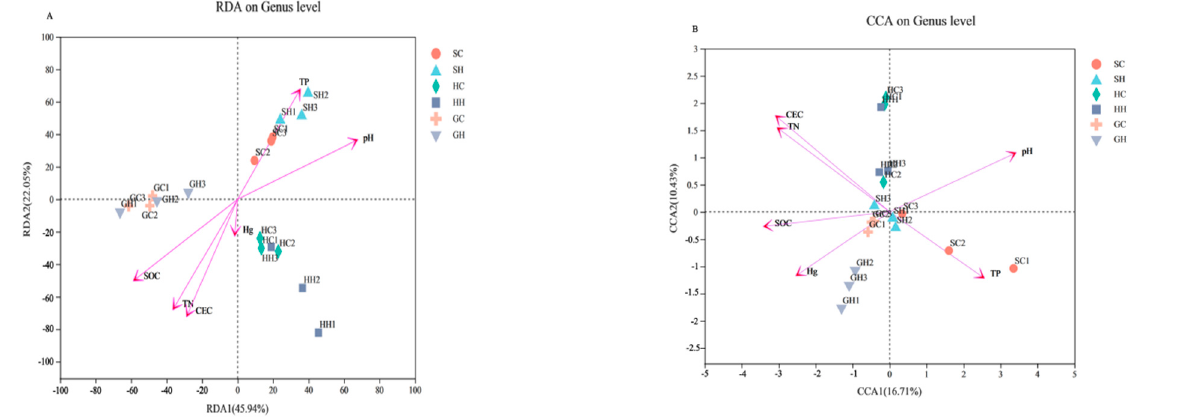
Figure 6. Redundancy analysis revealed the correlations of soil properties and heavy metals at the sample. ( A ) bacteria; ( B ) sample. ( A ) bacteria; ( B ) fungi.